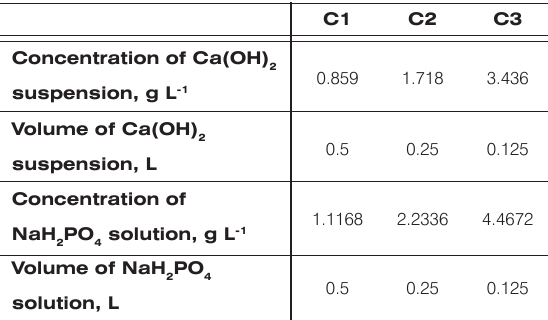
Table 1. Characteristics of precursor suspensions/solutions for